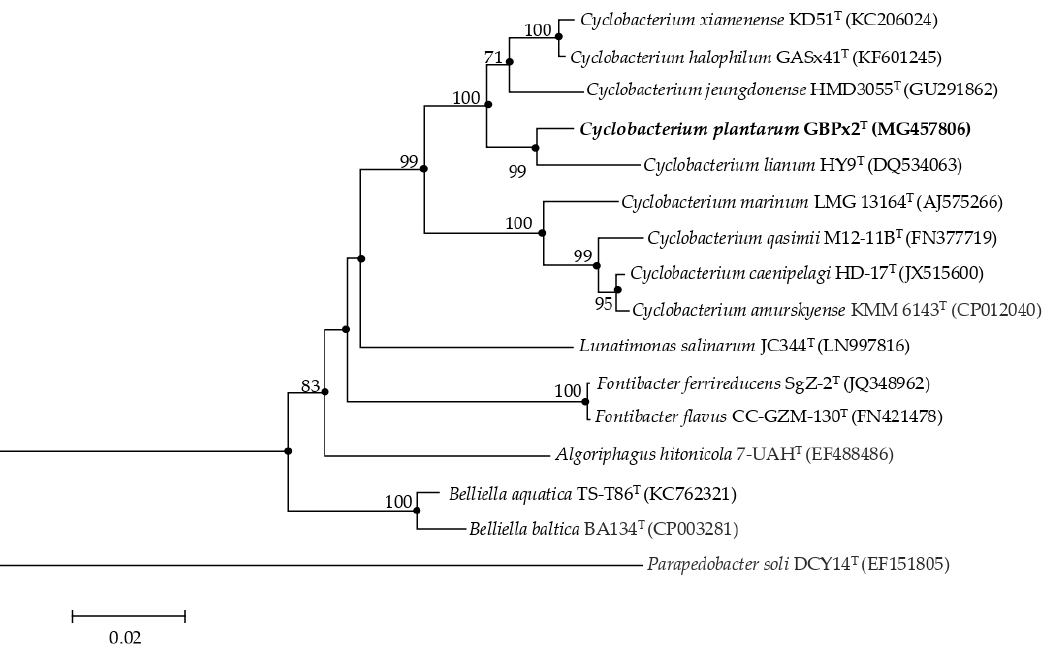
Figure 1. Maximum-likelihood phylogenetic tree based on the 16S rRNA gene sequence comparison, showing the relationships between strain GBPx2 T and members of the family Cyclobacteriaceae . Filled circles indicate nodes that were also obtained in trees based on minimum-evolution and maximum-likelihood algorithms. Bootstrap values (for 1000 replicates) over 70% are shown at the nodes. The sequence accession numbers are shown in parenthesis. Bar, 2% estimated sequence divergence. The sequence of Parapedobacter soli DCY14 T (EF151805) was used as outgroup. This phylogenetic tree shows that the genus Cyclobacterium is not monophyletic; the species of this genus are grouped into two clearly di ff erentiated branches supported with 100% values of